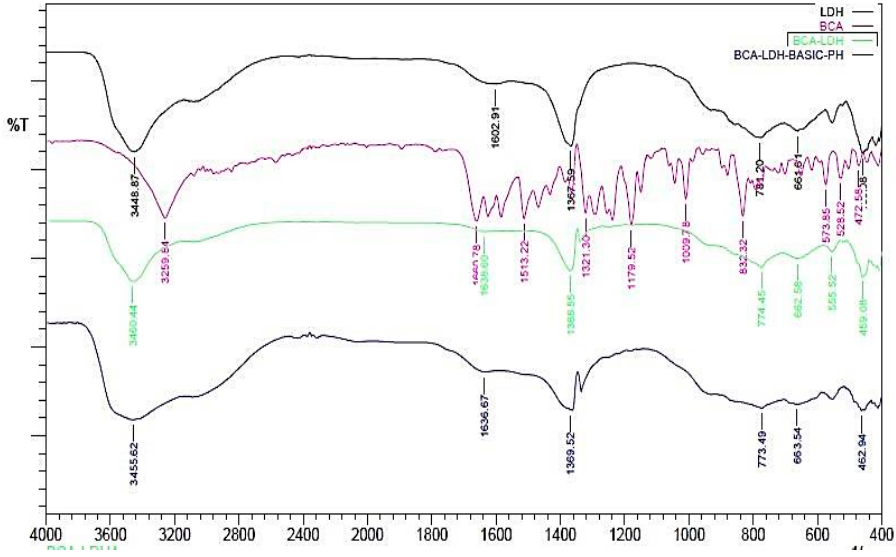
Figure 2. Overlay of FTIR of BCA-LDH-I, BCA, and LDH. FTIR of BCA-LDH-C is represented in Figure 3. It consists of peaks corresponding to LDH as well as BCA. The broad peak at 3446 cm − 1 corresponds to the OH − 1 peak of LDH. The peak at around 1600 cm − 1 corresponds to C=O stretching, which confirms the bond between the methoxy group of BCA and the OH − 1 of the interlayer water